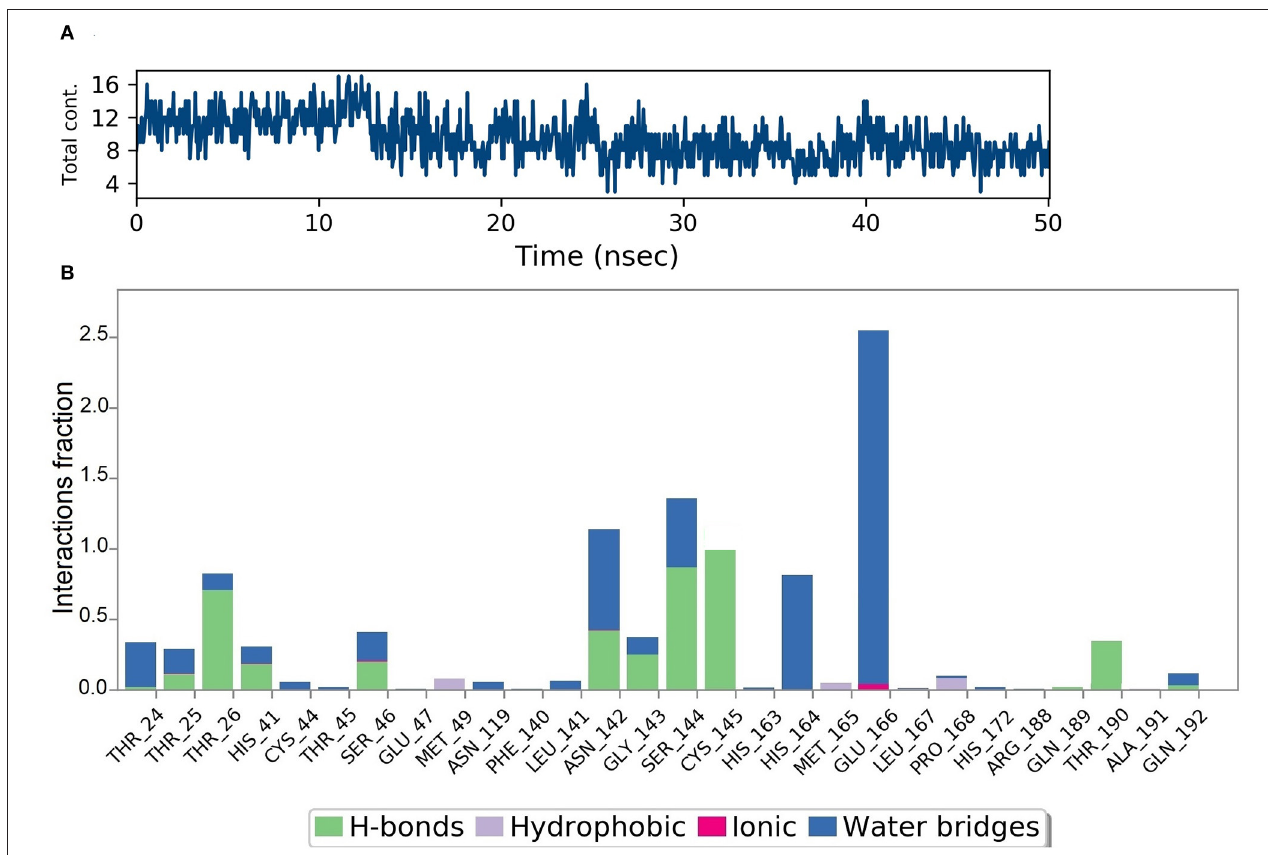
FIGURE 10 | Results of MD of DMO-SARS-CoV-2 M pro complex. (A) Timeline of the total contacts between DMO and M pro . (B) Interactions fractions during simulation time. Cys145 of M pro, a crucial residue for inhibition of M pro , maintained hydrogen bonds with DMO for 100% of simulation time.